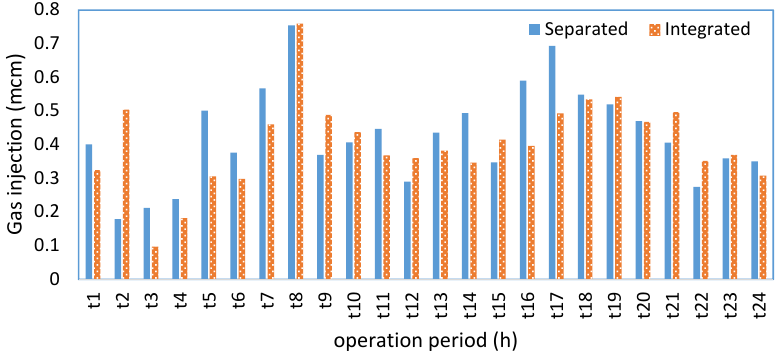
Figure 5. Total amount of gas injected from the terminal to the network in integrated and separated methods. Table 1. Operation Cost of NGEN.